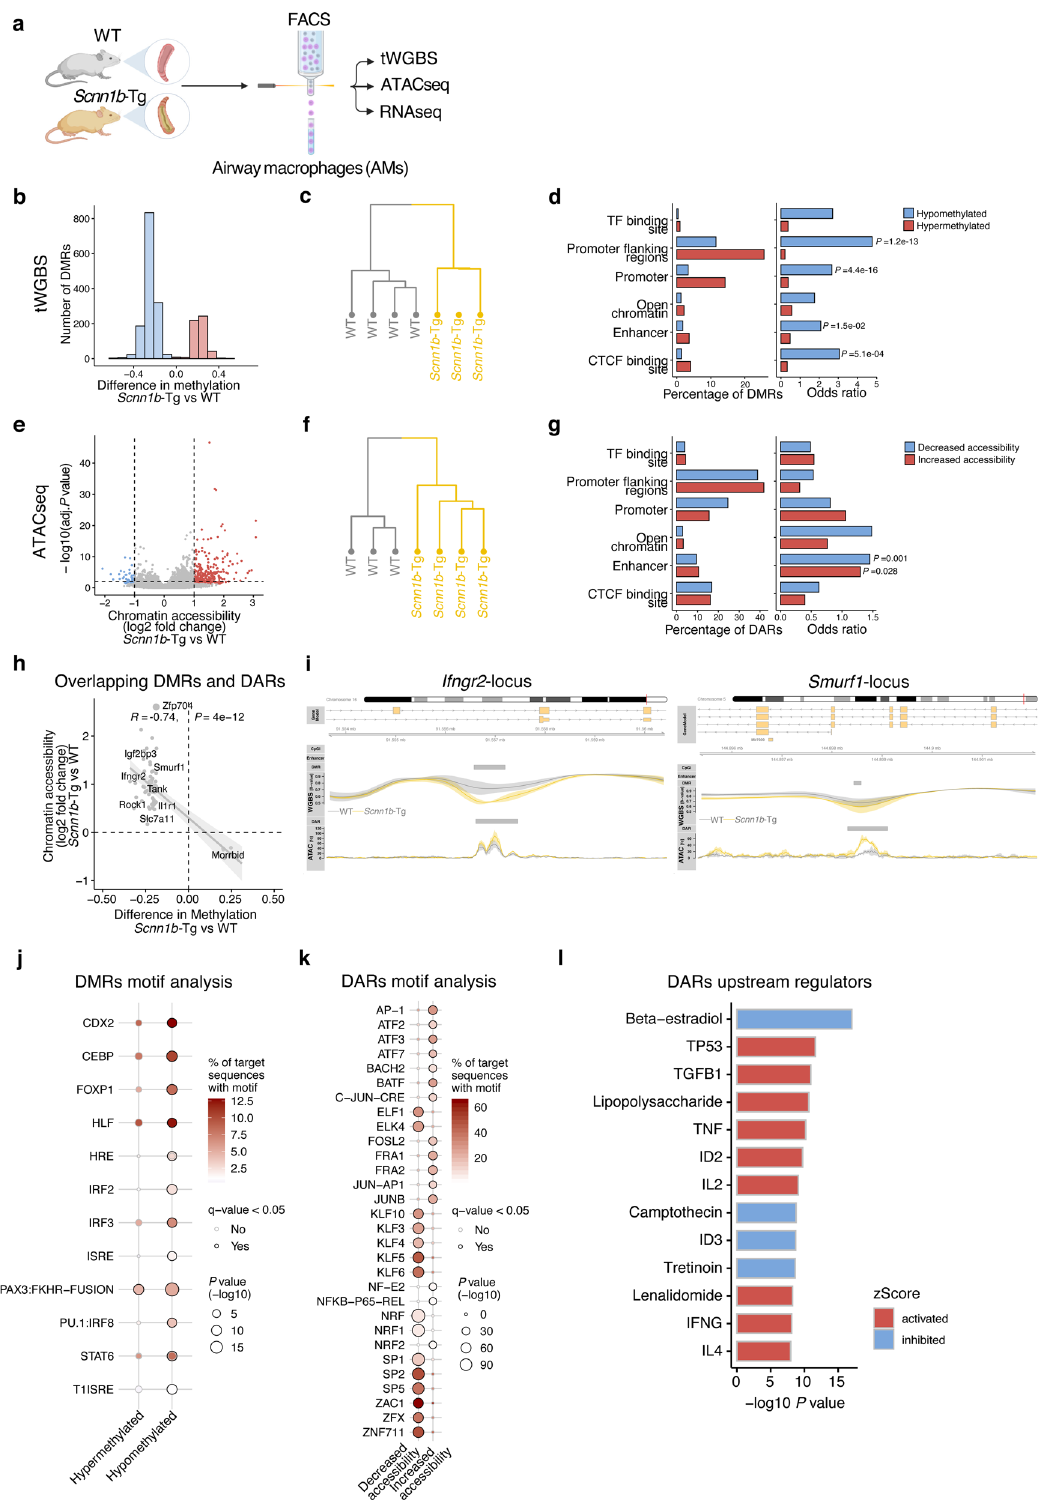
between DMRs and DARs, with a strong and signi fi cant inverse correlation (Pearson correlation: R = − 0.74; P value < 0.001), associated with 58 genes. This included coherently hypomethy- lated loci with increased accessibility in Scnn1b -Tg AMs for genes involved in cytokine signaling, such as Tank , Il1r1 , or the negative regulator Smurf1 , as well as genes previously shown to be associated with chronic lung diseases (e.g., Infgr2 , Zfp704 , and